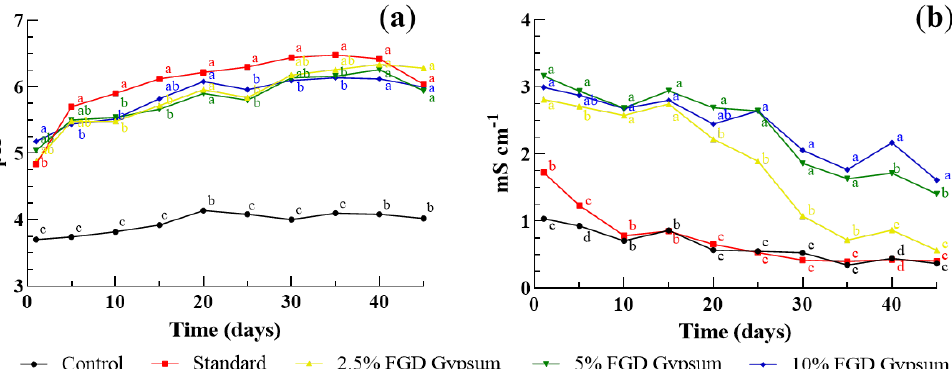
Figure 1. The effect of substrate amendments on leachate ( a ) pH and ( b ) electrical conductivity over time in daily-irrigated pine bark columns. Substrate treatments consisted of neither dolomitic limestone nor flue gas desulfurization (FGD) gypsum (Control), 4.15 kg m − 3 dolomitic limestone (Standard), dolomitic limestone and 2.5% ( v / v ) FGD gypsum, dolomitic limestone and 5% FGD gypsum, or dolomitic limestone and 10% FGD gypsum. All reported values are lsmeans. Treatment effects were analyzed using Tukey ’ s honest significant difference by day. Values containing the same letter were not significantly different ( p > 0.05).